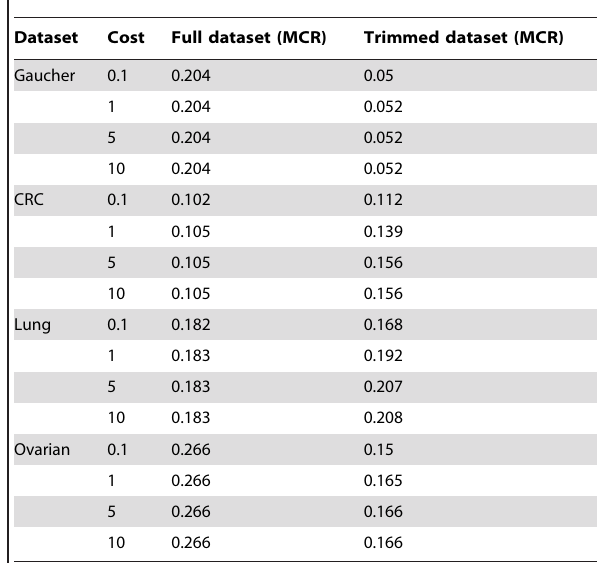
Figure 3. Summary of Misclassification results for all classifiers. Summary of mean MCR results for each of the optimised classifiers on each trimmed dataset. These results demonstrate the MCR for each classifier using the optimal number of reduced components from the PLS-LDA (excluding SVM). Gaucher data uses a 7 component model, the LC data uses a 5 component model, the CRC data uses a 6 component model and the OC data uses a 3 component model for each.